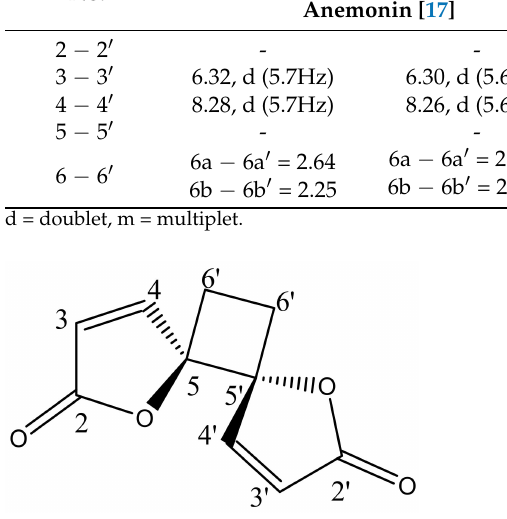
Figure 1. Structural formula of